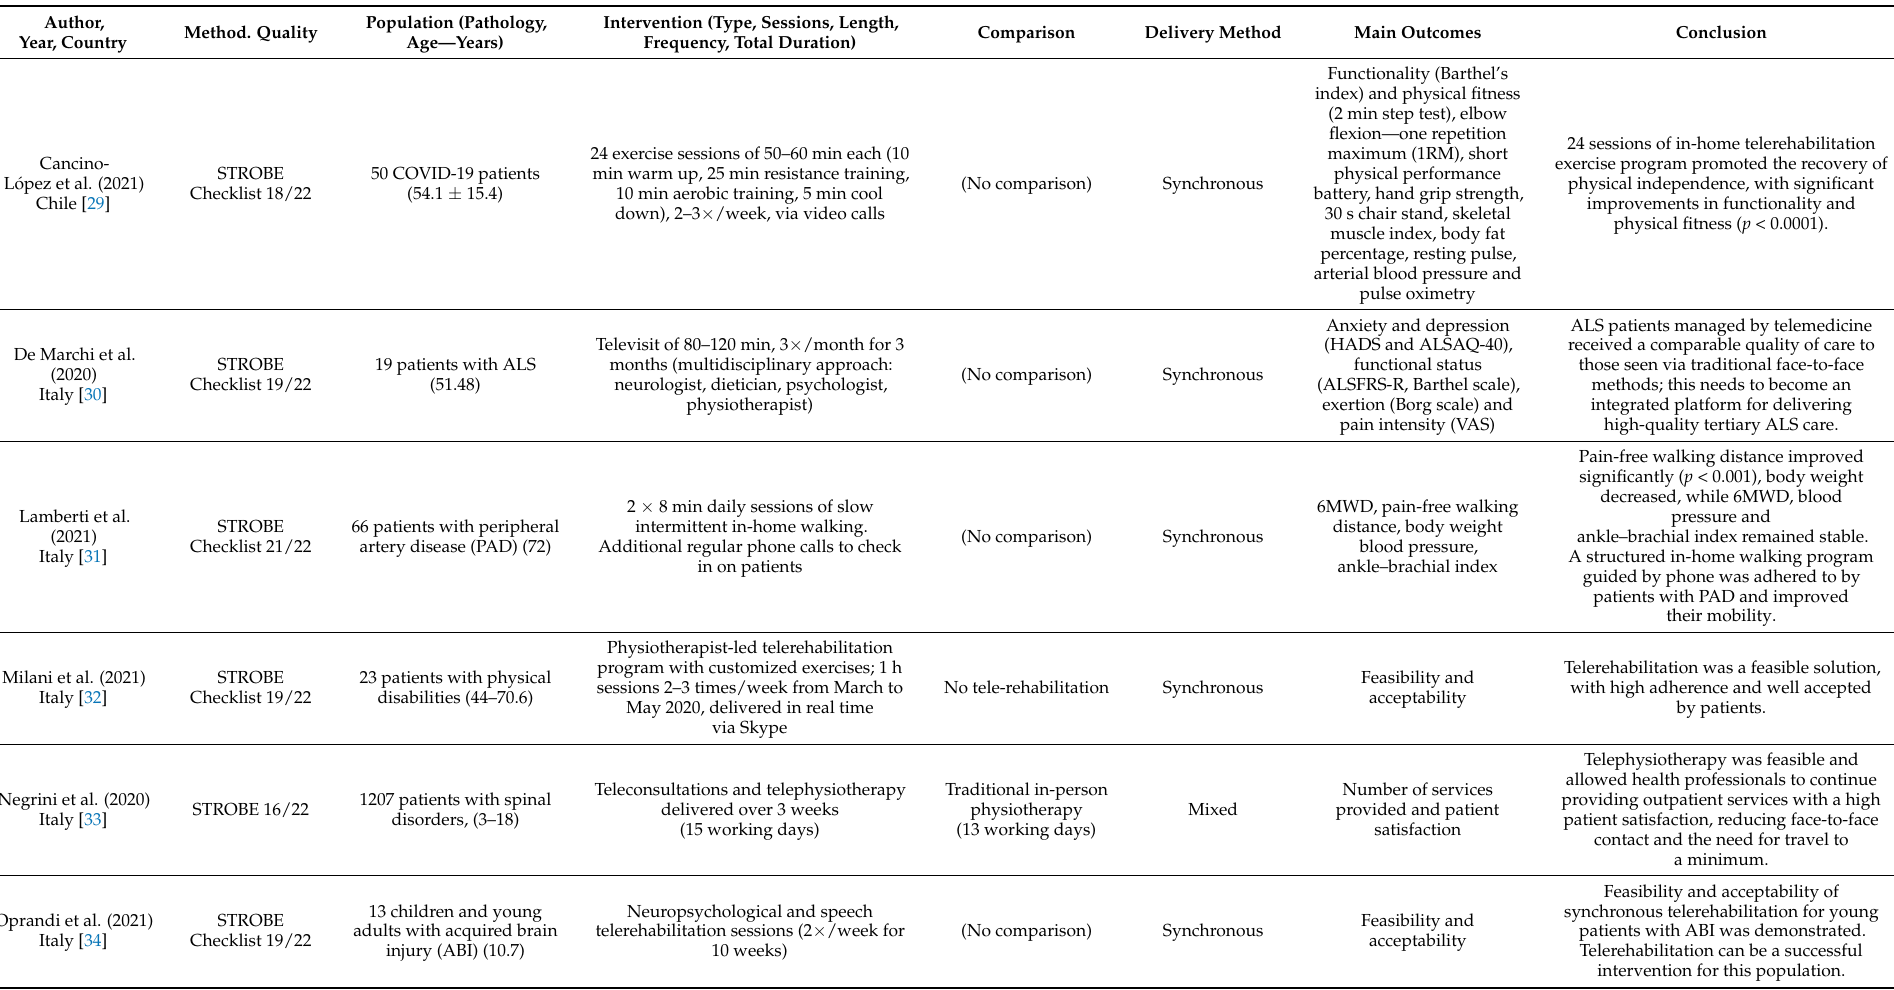
Table 2. Characteristics of the observational studies included in the